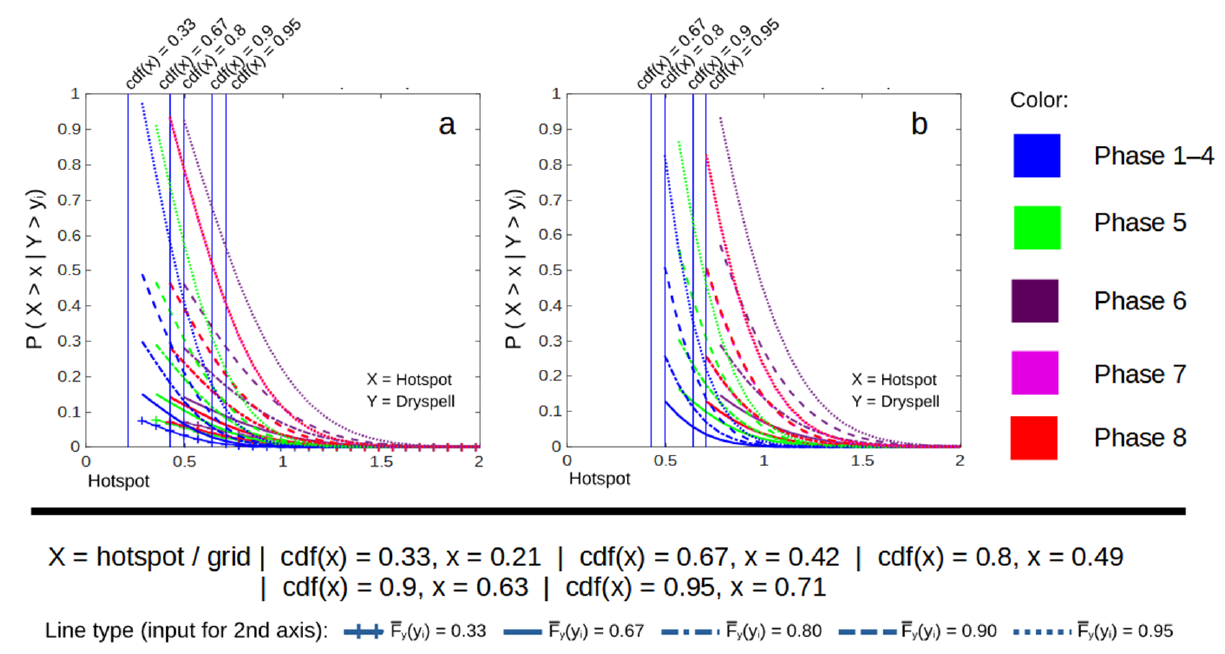
Figure 12. Conditional survival probability of hotspot when the climate dry spell conditions are at least in a. normal conditions and b. dry conditions for 2001–2020 data.